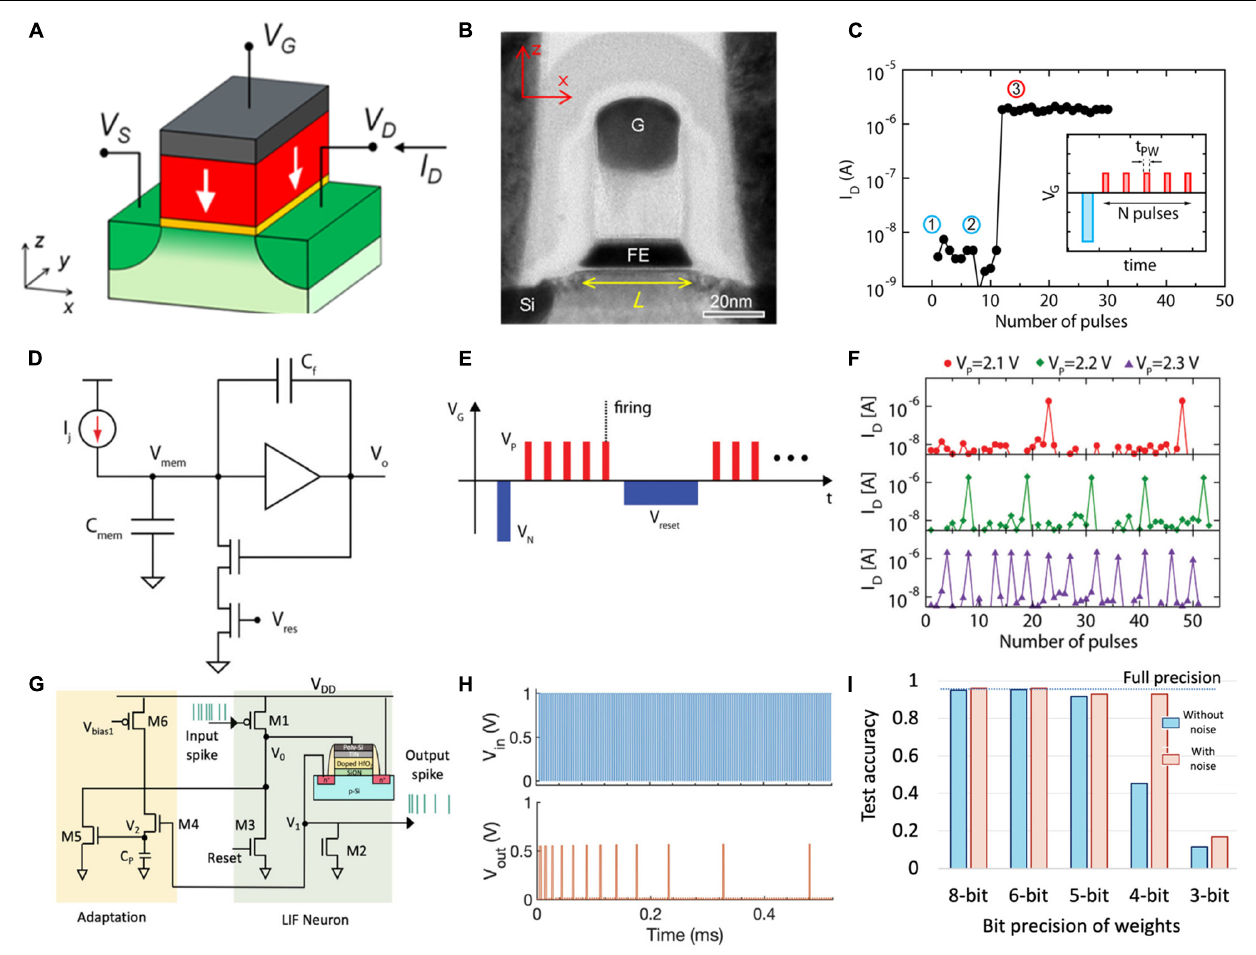
FIGURE 7 | (A) Structure of a nanoscale ferroelectric transistor. (B) Transmission electron microscopy (TEM) image of a ferroelectric transistor device. (C) Accumulative polarization reversal in ferroelectric transistors. The inset depicts the sharp switching from OFF to ON after receiving several identical impulses. (D) Schematic of an axon-hillock complementary metal–oxide–semiconductor (CMOS) neuron. (E) Pulsing scheme for implementing an integrate-and-fire (IF) cycle and an arbitrary refractory period, after which a new IF cycle begins (Mulaosmanovic et al., 2018a). (F) Consecutively repeated IF cycles for different values of V P . (G) Circuit implementation of a ferroelectric field-effect transistor (FeFET)-based spiking neuron. The leaky integrate-and-fire (LIF) neuron is implemented using one FeFET and three transistors (M1–M3). Biologically inspired homeostatic plasticity is implemented using additional transistors (M4–M6). (H) The decreasing output spike frequency exhibiting spike-frequency adaptation. (I) Comparison of test accuracies for different bit precisions of weights with and without noise (Dutta et al.,